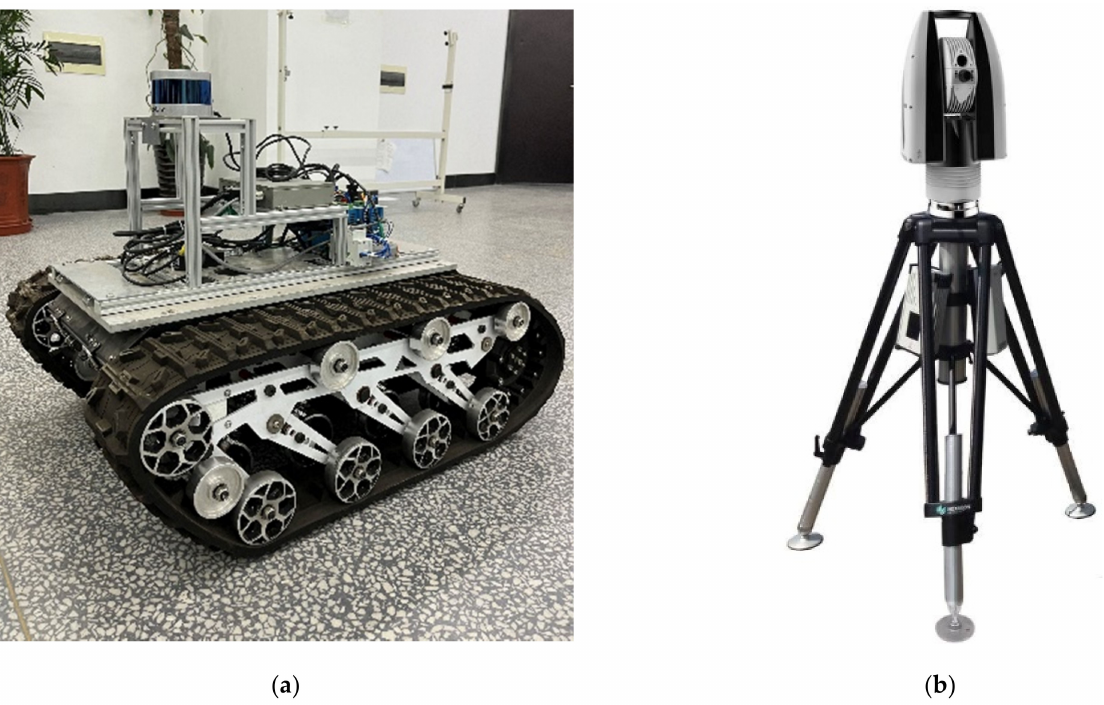
Figure 18. Experimental equipment. ( a ) shows the mobile robot platform and ( b ) shows the Leica Geosystems absolute tracker (AT960).